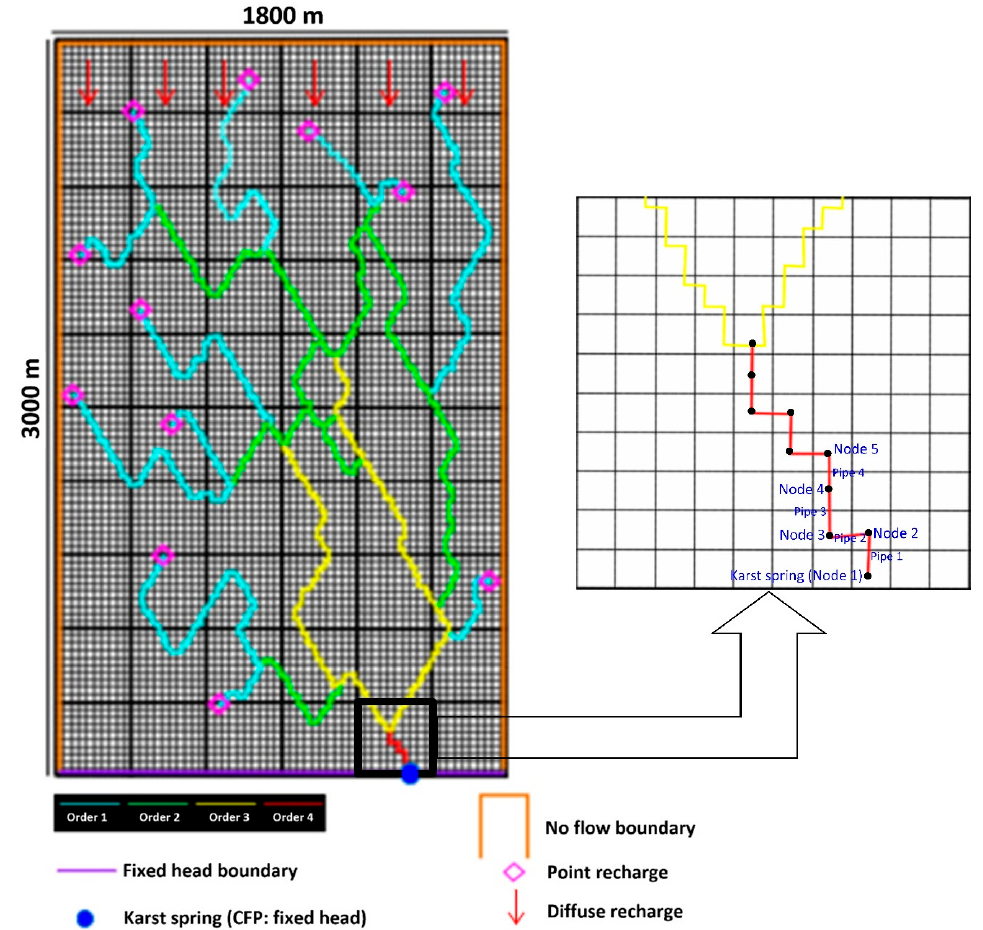
Figure 5. Plan view of the model used for the Figure 6. Plan view of the model used for the simulations.